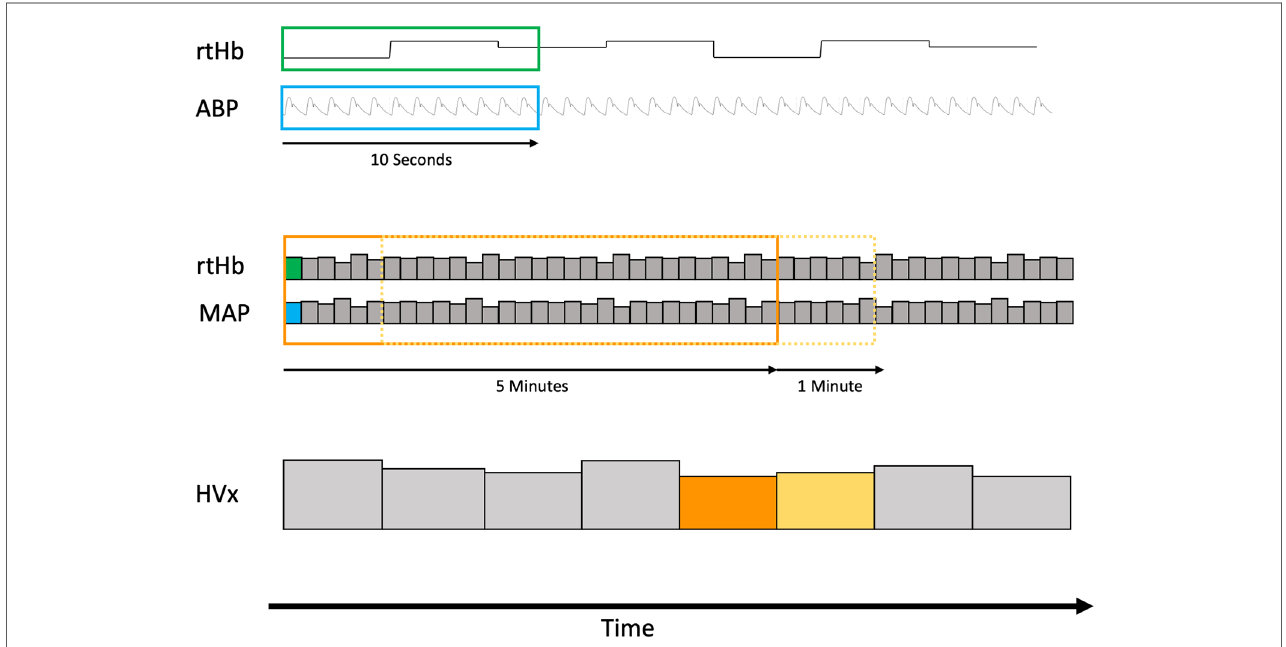
FIGURE 1 Schematic diagram of how the hemoglobin volume index (HVx) is calculated. The fi rst row demonstrates raw input data of continuous arterial blood pressure and relative total hemoglobin (rtHb) at their respective sampling frequency. Raw data are averaged over 10 s. In total, 30 pairs or 5 min of MAP and rtHb were used to calculate the fi rst HVx. For each minute, a successive HVx is than calculated including the last 30